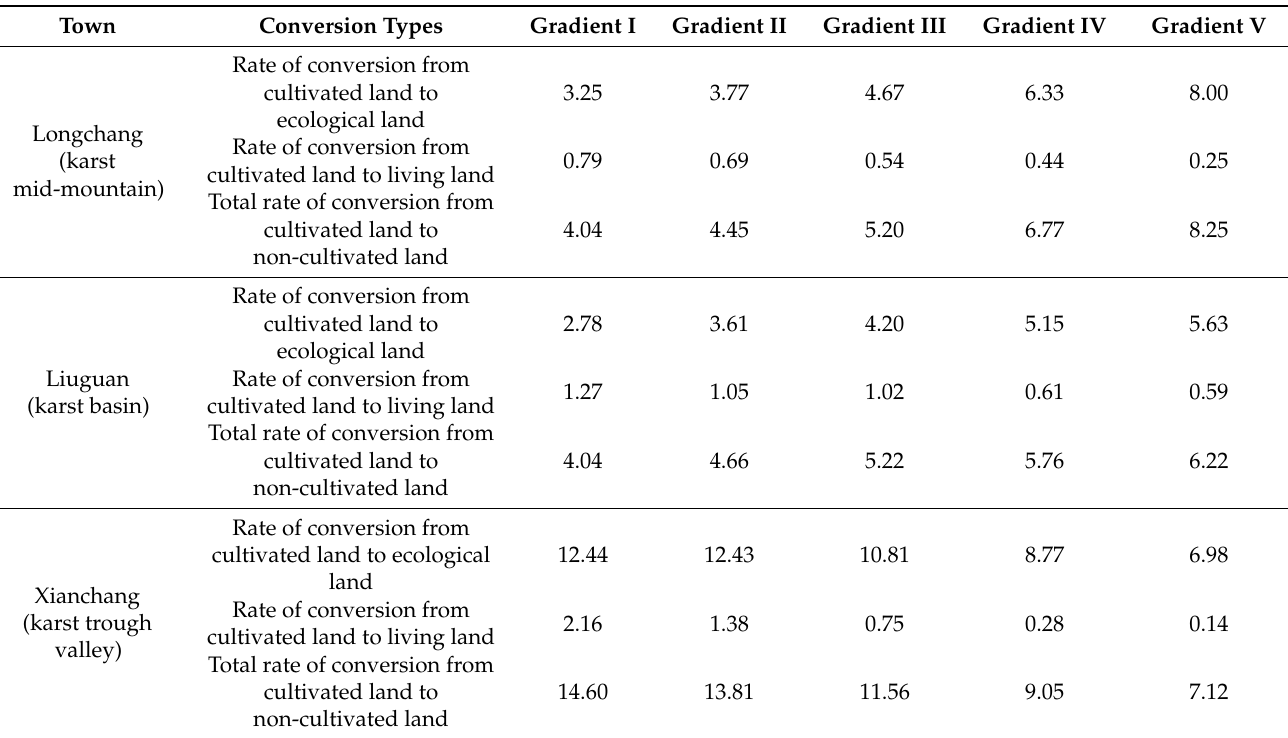
Table 4. The slope gradient characteristics of the non-agriculturalization of cultivated land from 2010 to 2020